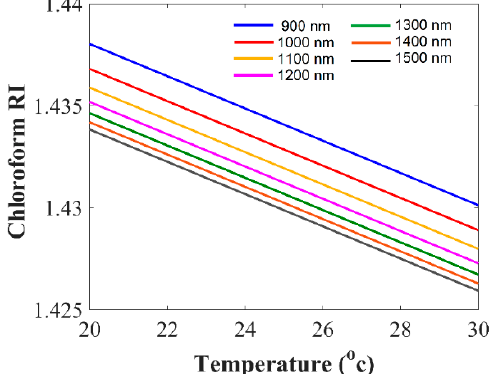
Figure 3. Chloroform refractive index as a function of temperature for different excitation wavelengths.